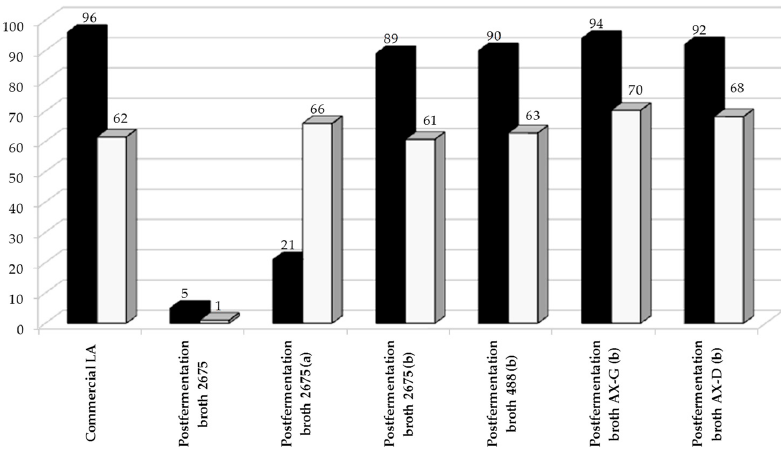
Figure 8. Catalytic conversion of lactic acid in post-fermentation media purified to various degrees ( —X (%)) and selectivity to propylene glycol ( —S PG (%)). Lactic acid was obtained through